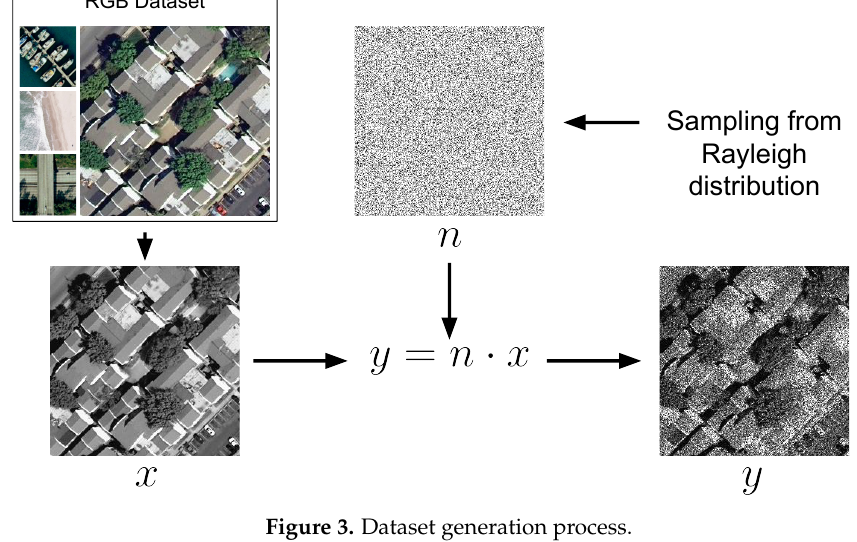
Figure 3. Dataset generation